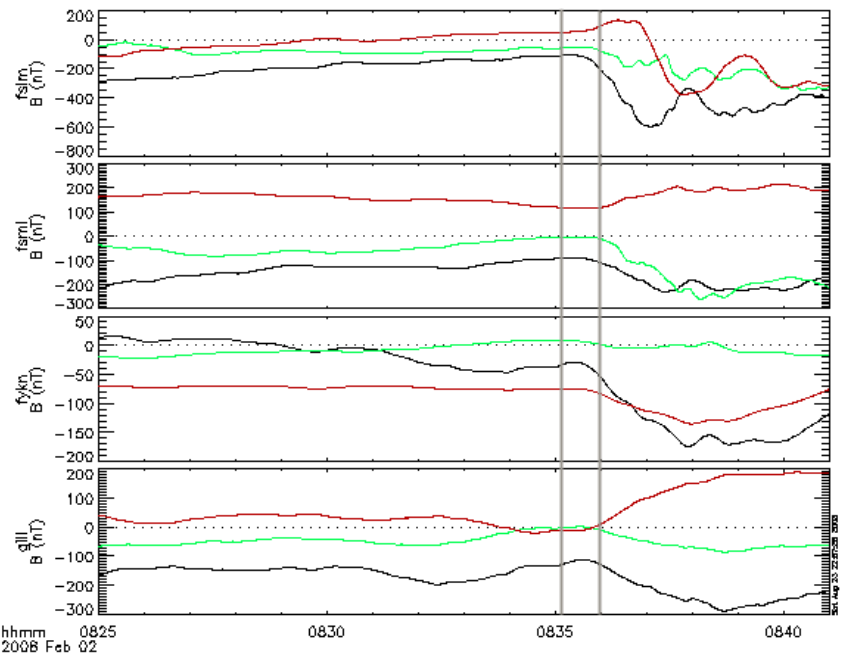
Figure 17 Ground base magnetometer data shows the largest magnetic signature at Fort Simpson in agreement with the optical data.